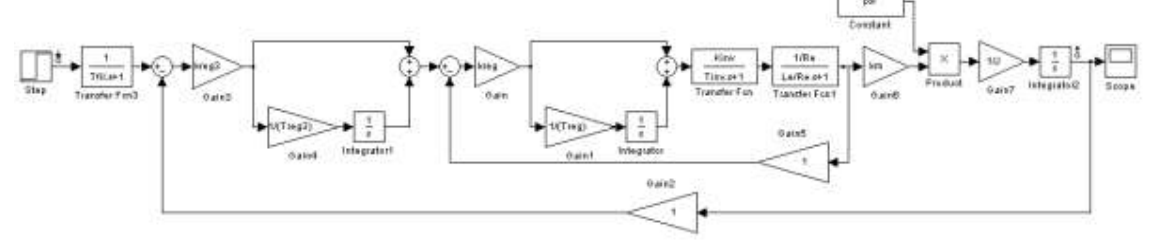
Figure 9. Simulation model of the speed loop that is tuned on symmetrical optimum